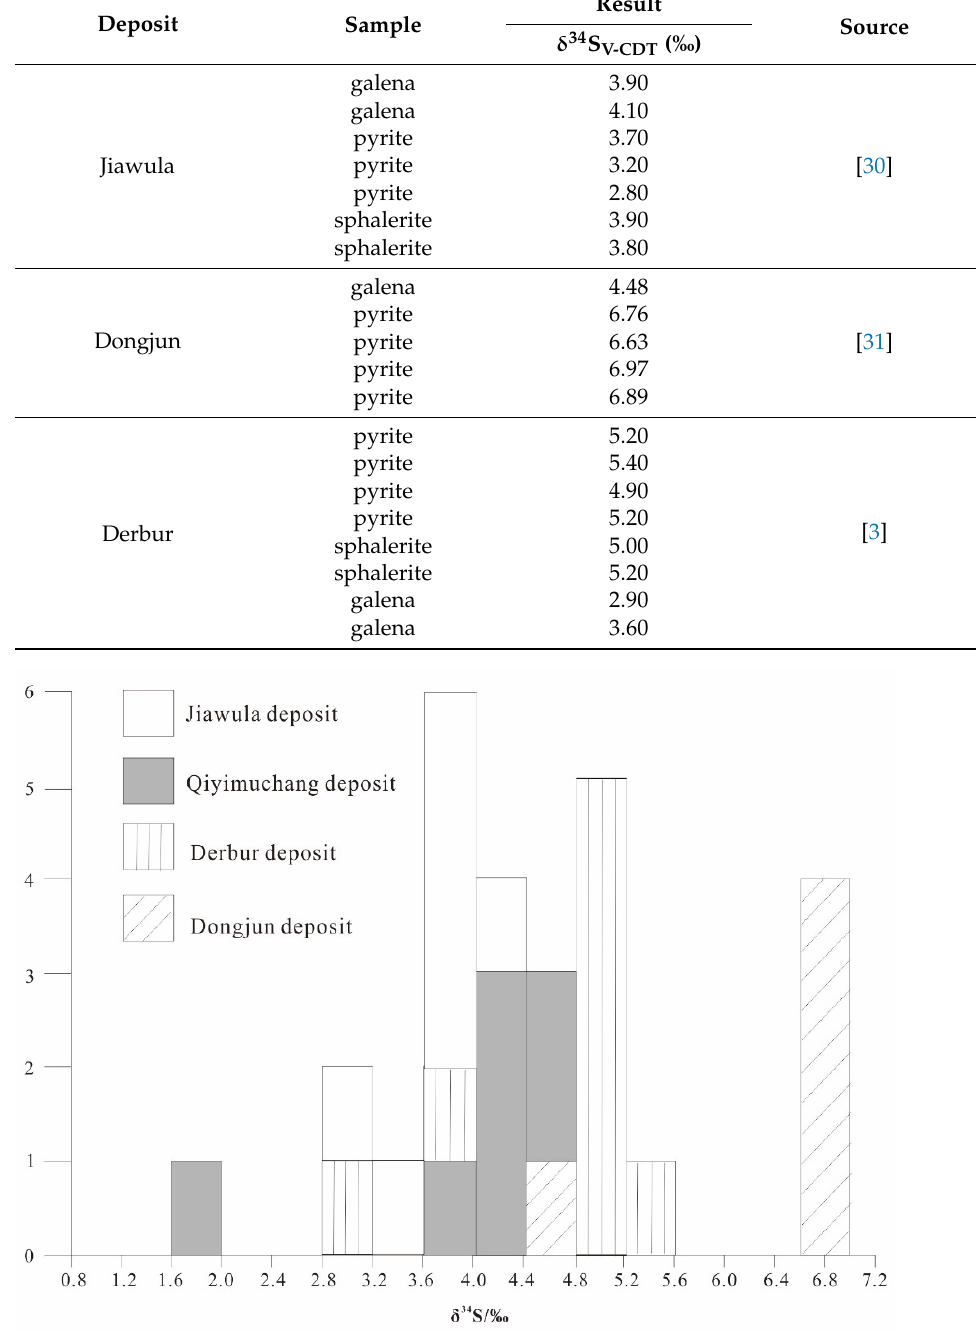
Figure 7. Sulfur isotope abundances of sulfide in typical lead zinc deposits in Erguna metallogenic belt. The test results were consistent with those of the sulfur isotope analysis. The lead isotopic compositions of seven pyrite and sphalerite samples and other deposits in the same area are listed in Table 3. The analysis results show that the changes of 208 Pb/ 204 Pb, 207 Pb/ 204 Pb, and 206 Pb/ 204 Pb are relatively stable at 38.15–38.39, 15.55–15.62, and 18.33– 18.41, respectively. The distribution range is relatively concentrated and the change is small, indicating that the lead in the sulfide of the Qiyimuchang deposit has the characteristics of normal lead